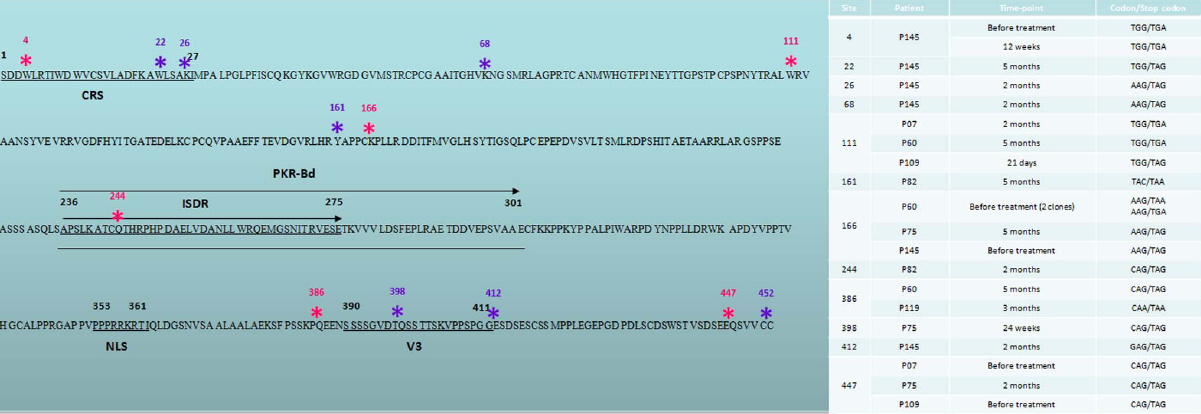
Figure 6. Stop Codon. Graphic representation of sites where stop codons were identified. Pink – more than one occurrence; purple-one occurrence. NZL1 (GenBank accession number D17763) – reference sequence for genotype 3 was used for the graphic representation. CRS – cytoplasmic retention site; PKR-Bd – PKR binding region; ISDR – IFN sensitivity determining region; NLS – nuclear localization signal; V3– variable region